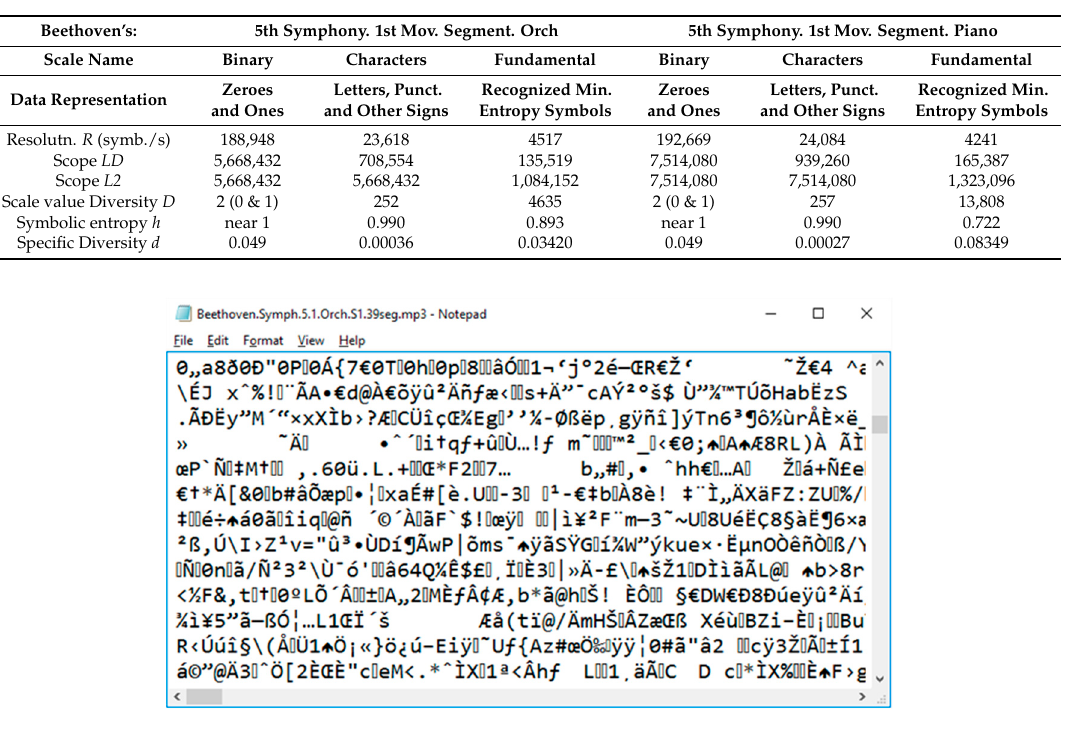
Figure 6. A tiny fraction of the text which constitutes the Beethoven’s 5th symphony 1st movement segment interpreted with orchestra. Extracted from an .MP3 sound recorded file.